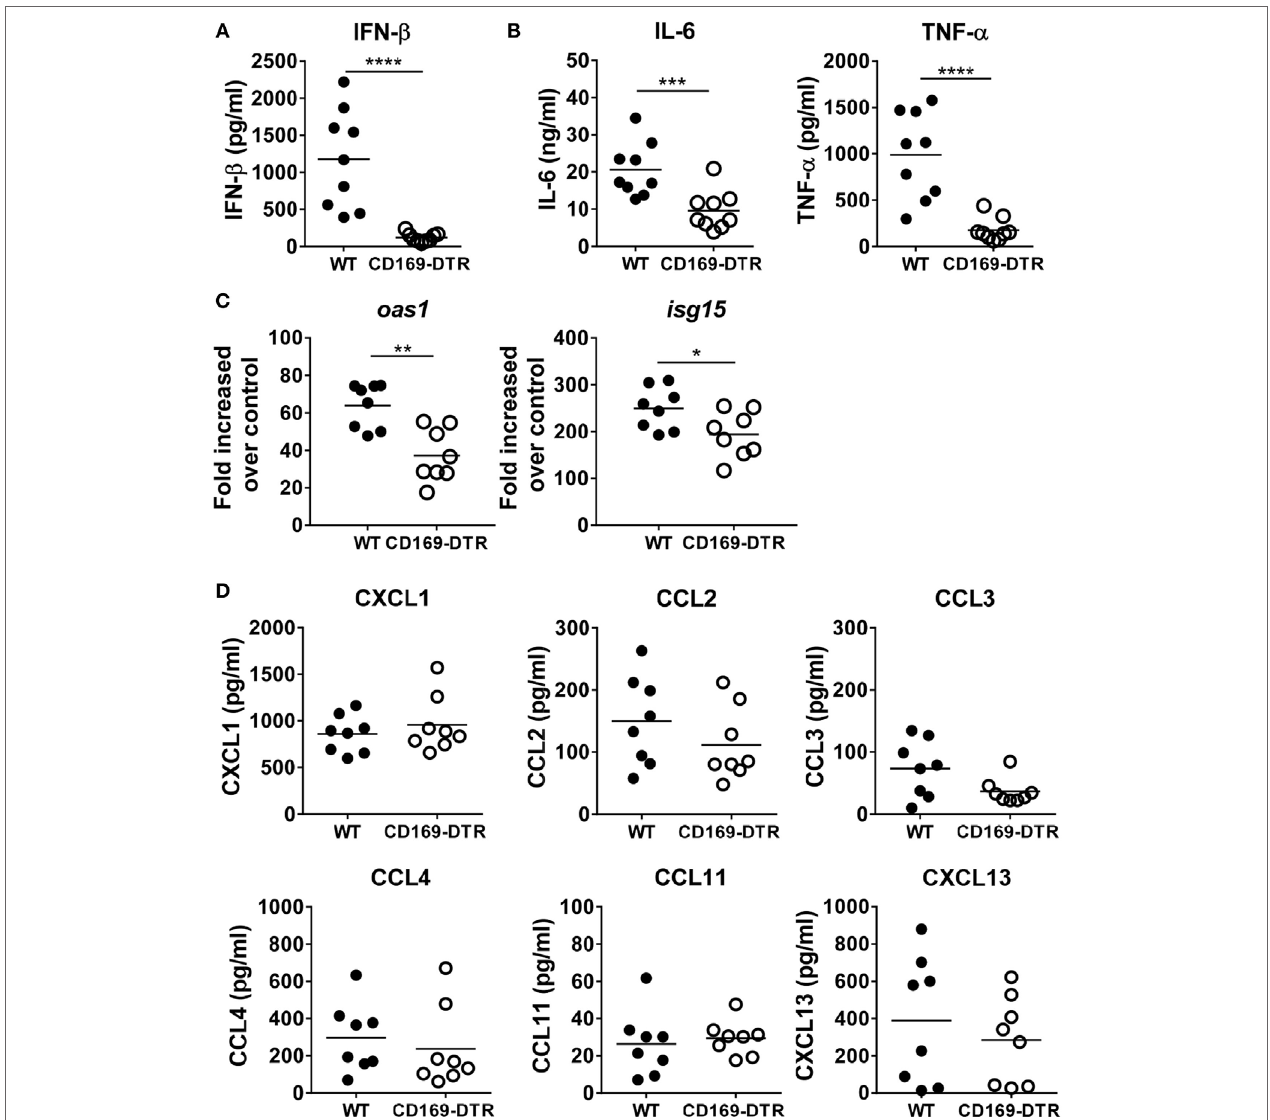
FigUre 2 | CD169 + cell depletion diminishes innate cytokine secretion into bronchoalveolar lavage (BAL) fluid during respiratory syncytial virus (RSV) infection. At the 9 h later of RSV infection, BAL fluid was collected from diphtheria toxin (DT)-treated wild-type (WT) and CD169-diphtheria toxin receptor (DTR) mice. The levels of interferon (IFN)- β (a) and IL-6 and TNF- α (B) were measured by ELISA. Each dot represents an individual mouse ( n = 9 in each group). (c) At the 1 day later of RSV infection, the levels of Oas1 and Isg15 mRNA expression in lung tissues from DT-treated WT and CD169-DTR mice were measured using real-time quantitative PCR. Hprt was used as an internal control. (D) At the 9 h later of RSV infection, the mouse chemokines CXCL1, CCL2, CCL3, CCL4, CCL11, and CXCL13 were monitored using a cytometric bead array. Each dot represents an individual mouse ( n = 8 in each group). Statistically significant differences between groups are indicated: * P < 0.05, ** P < 0.01, *** P < 0.001, **** P < 0.0001. Data are representative of three independent